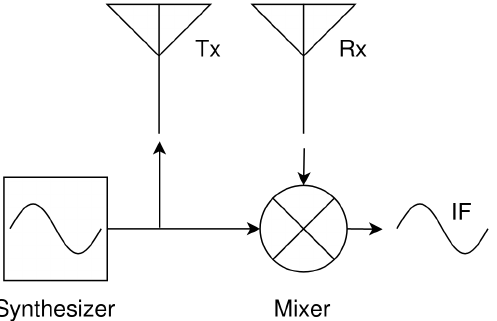
Figure 4. Typical FMCW radar